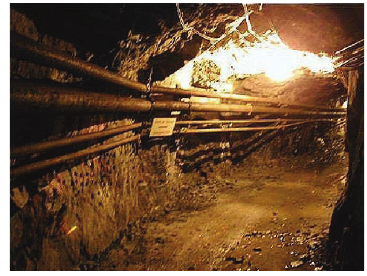
Figure 3: CANMET mine gallery-NLOS